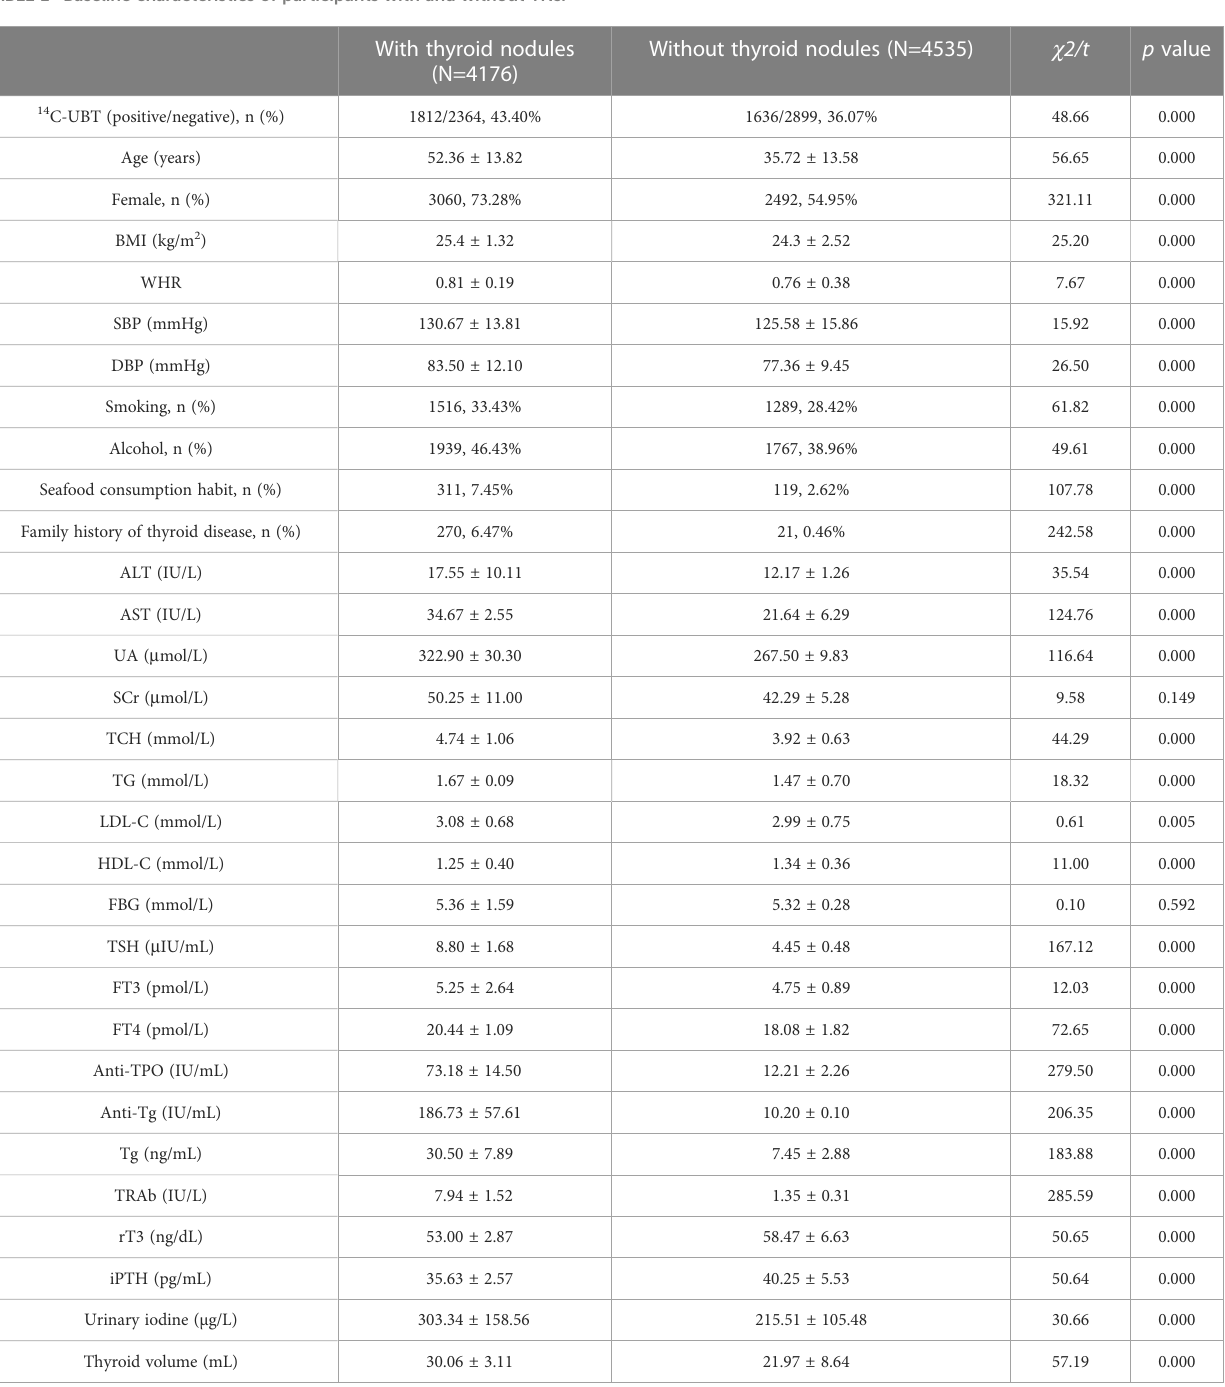
TABLE 1 Baseline characteristics of participants with and without TNs.